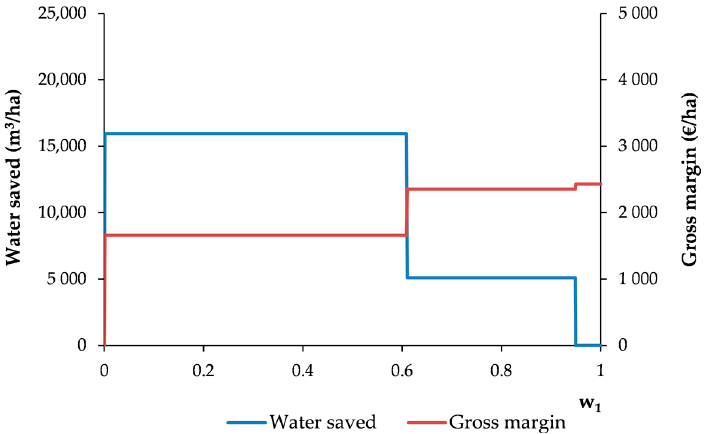
Figure 5. Water saved and gross margin with different sets of weights.